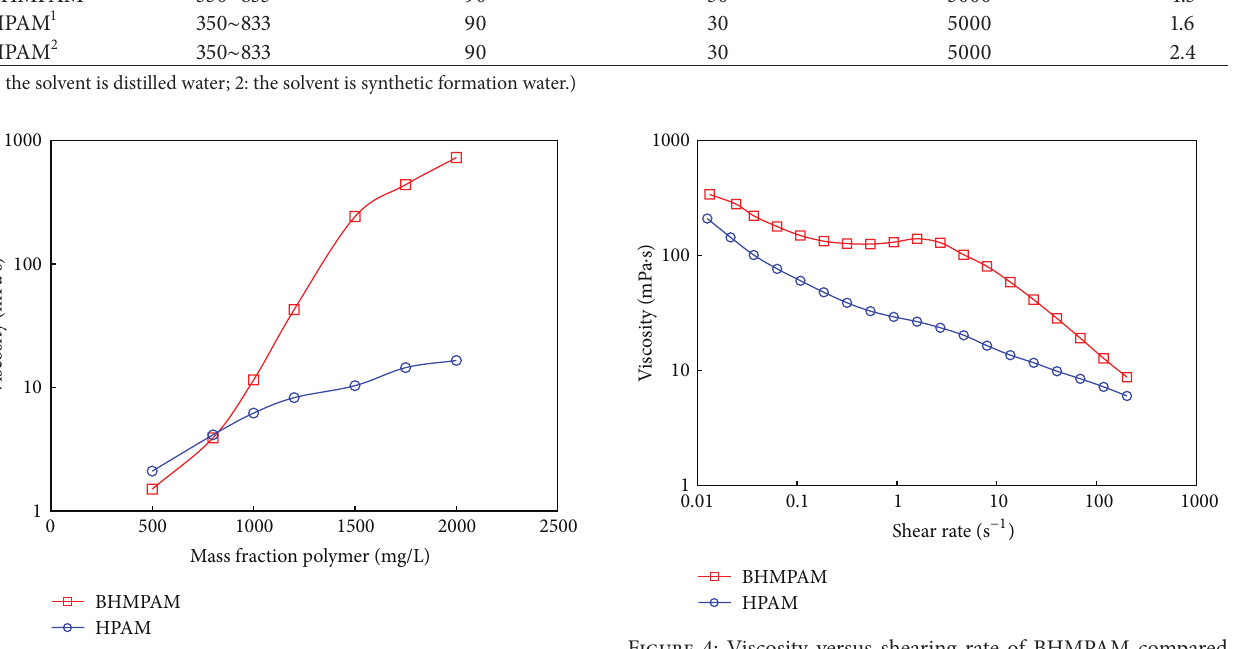
Figure 2: Viscosity versus polymer concentration of BHMPAM compared to HPAM in synthetic formation water.